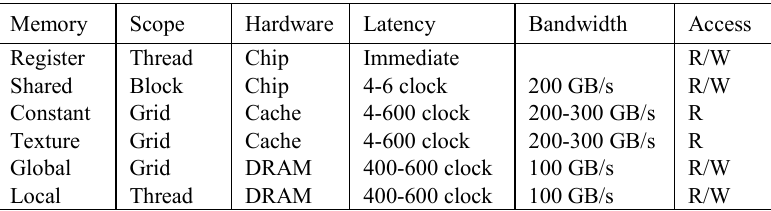
Table 1. Overview of memory architectures in CUDA